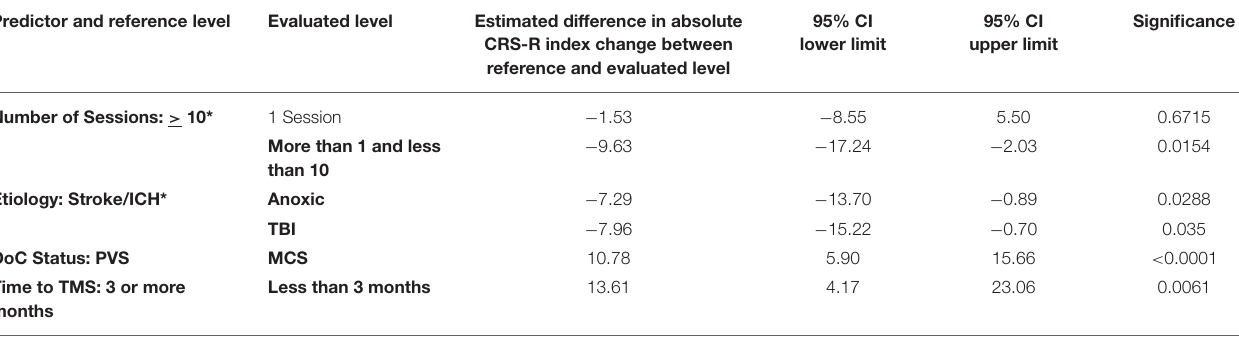
TABLE 6 | Significant predictors of absolute CRS-R index change in multivariate linear regression model. Predictor and reference